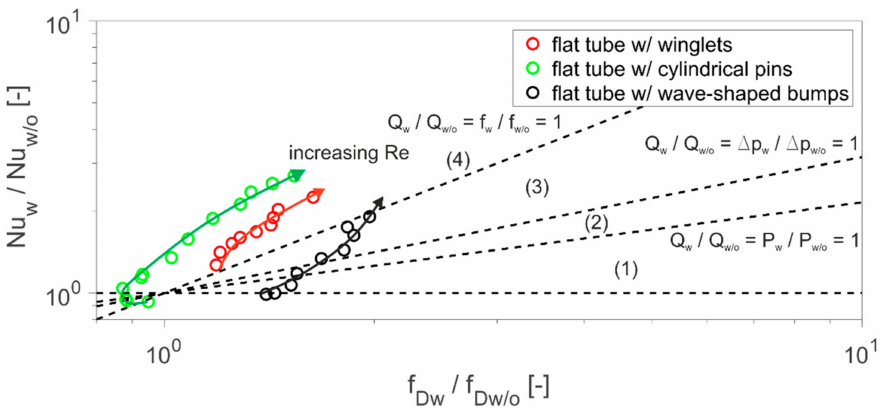
Figure 16. Efficiency in terms of performance evaluation plot (PEP) for Pr =